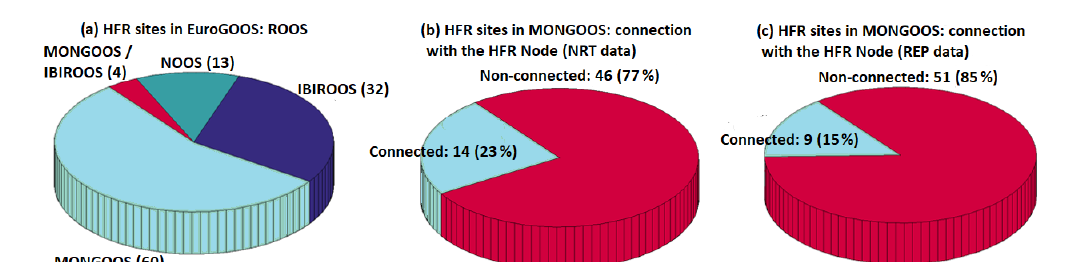
Figure 9. Pie charts showing the number and percentages of HFR systems in MONGOOS in terms of Regional Operational Oceanographic Systems (ROOS) alliances and integration of near-real-time (NRT) and reprocessed (REP) HFR data into the European HFR Node (Fig.